Question: Identify the chart type used in this figure.
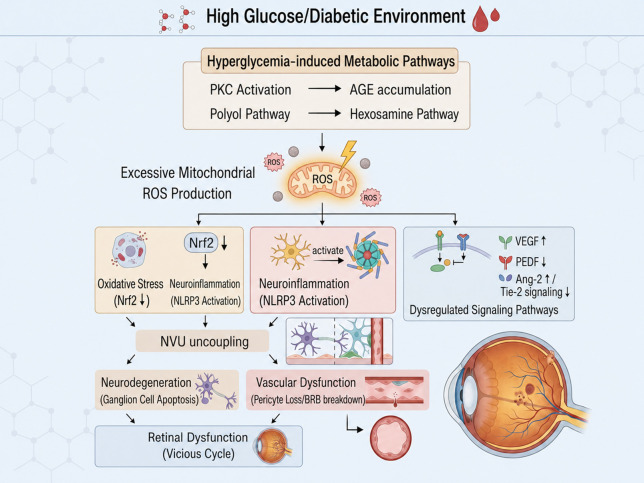
Answer: line